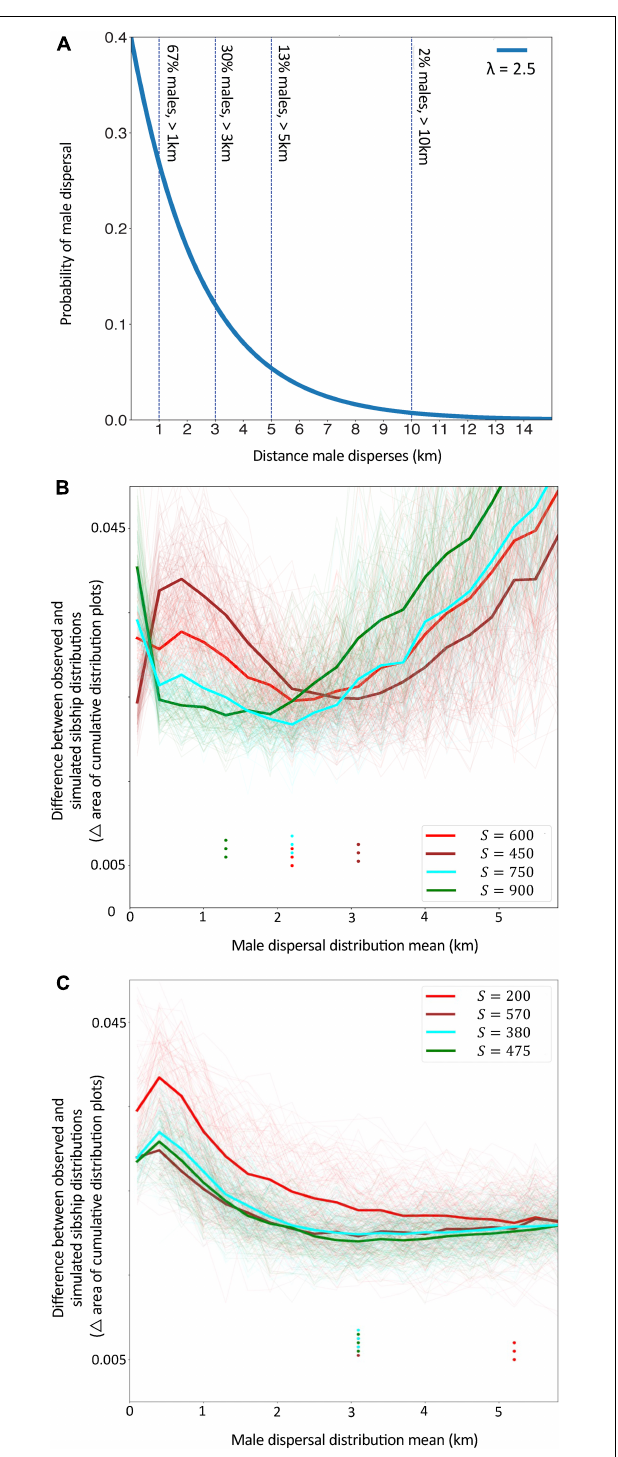
FIGURE 3 | (A) An example of the dispersal distributions of males being modeled in simulations; in this example the distribution has a mean value ( λ ) of 2.5 km. As indicated by the vertical lines, for this distribution around one third of males travel at least 3 km, one sixth travel more than 5 km and a small proportion travel more than 10 km. (B,C) The difference between simulated